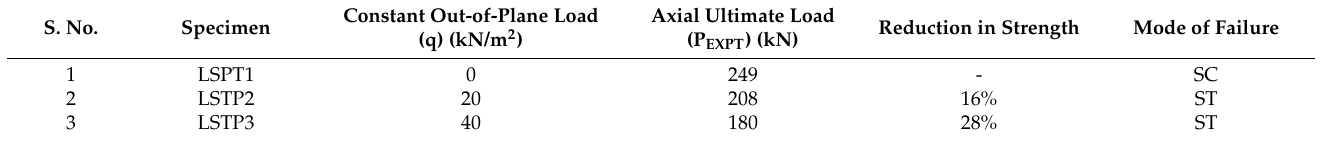
Table 8. Influence of out-of-plane load on the axial load of GFRP-stiffened composite plates. S. No.